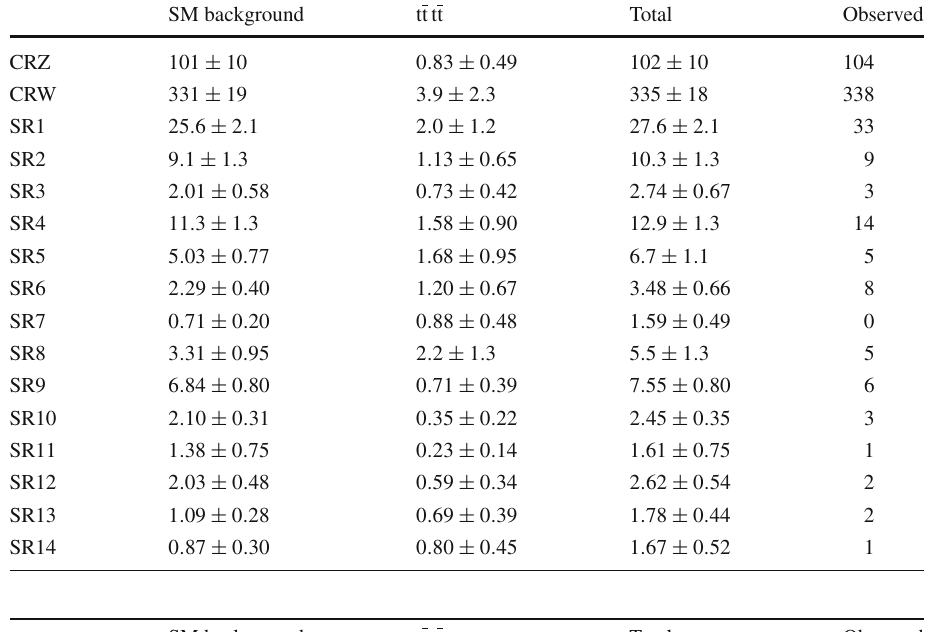
Table 4 The post-fit predicted background and tttt signal, and total yields with their total uncertainties and the observed number of events in the control and signal regions in data for the BDT analysis